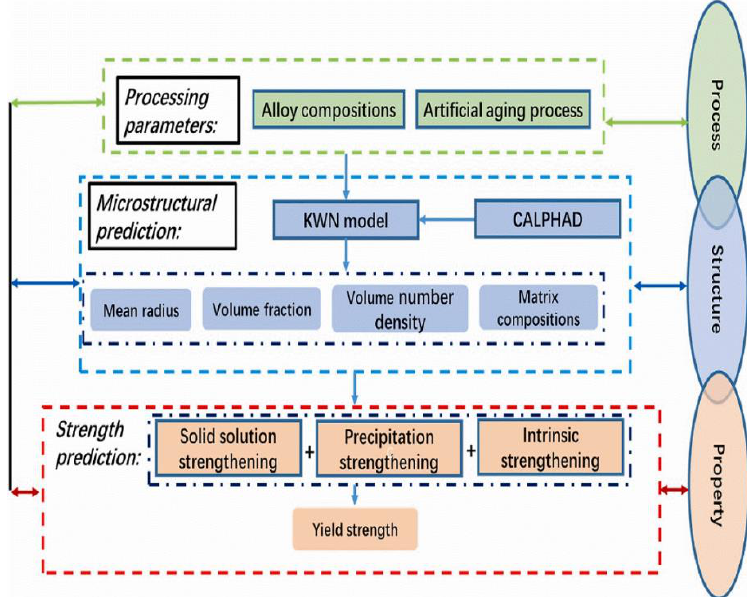
Figure 4. Flowchart of integrated microstructural and strength modeling framework methodology [20].